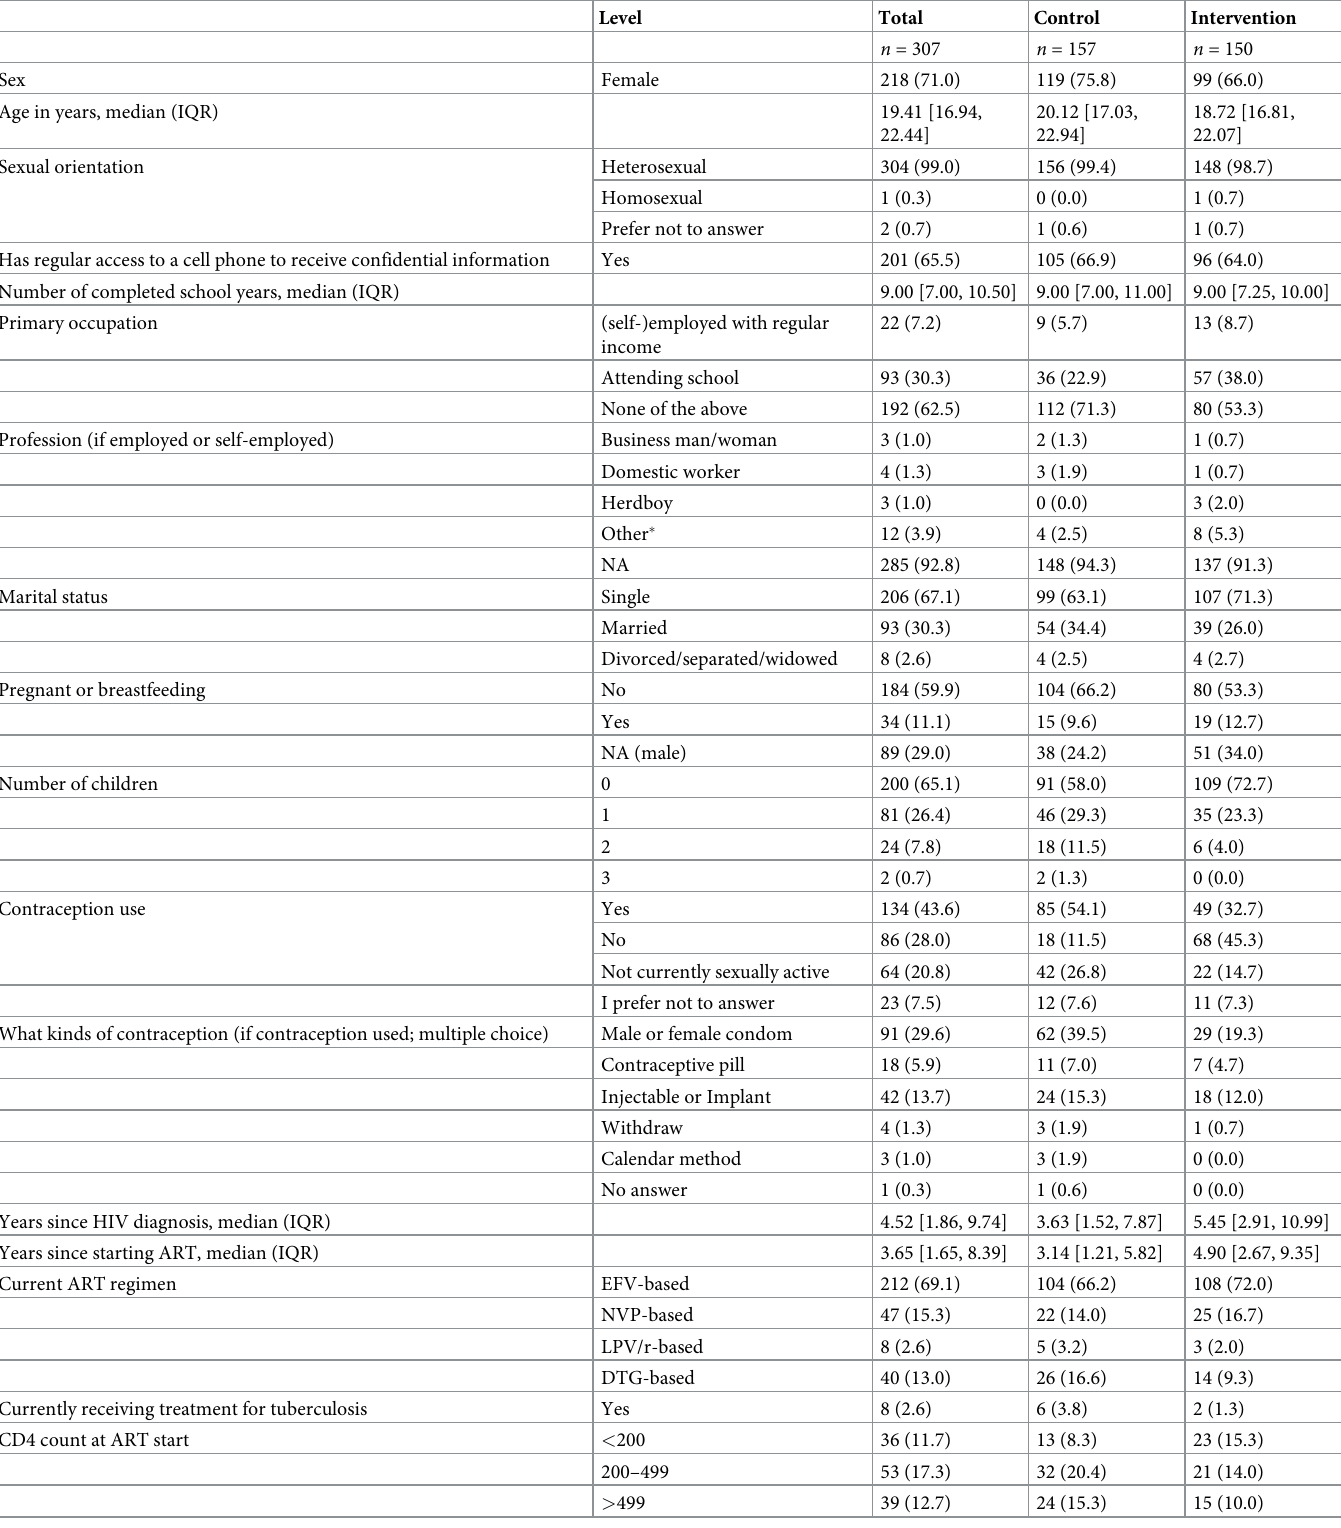
Table 1. Baseline characteristics of study